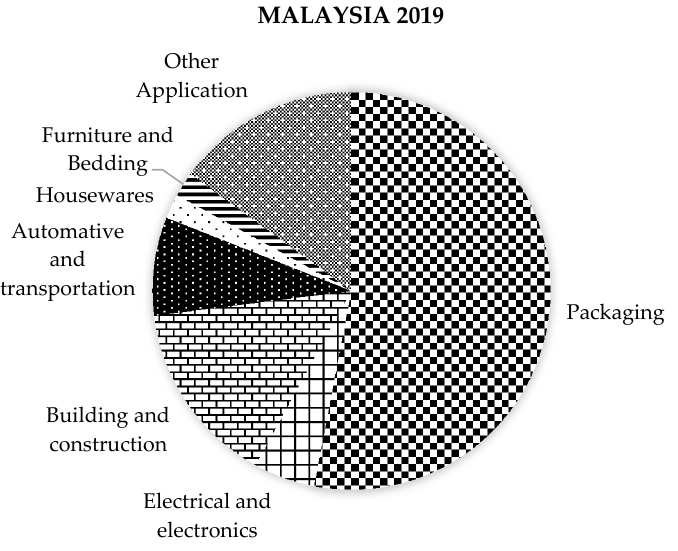
Figure 6. Composition of plastic market in Malaysia, 2019. Data adapted from [85].